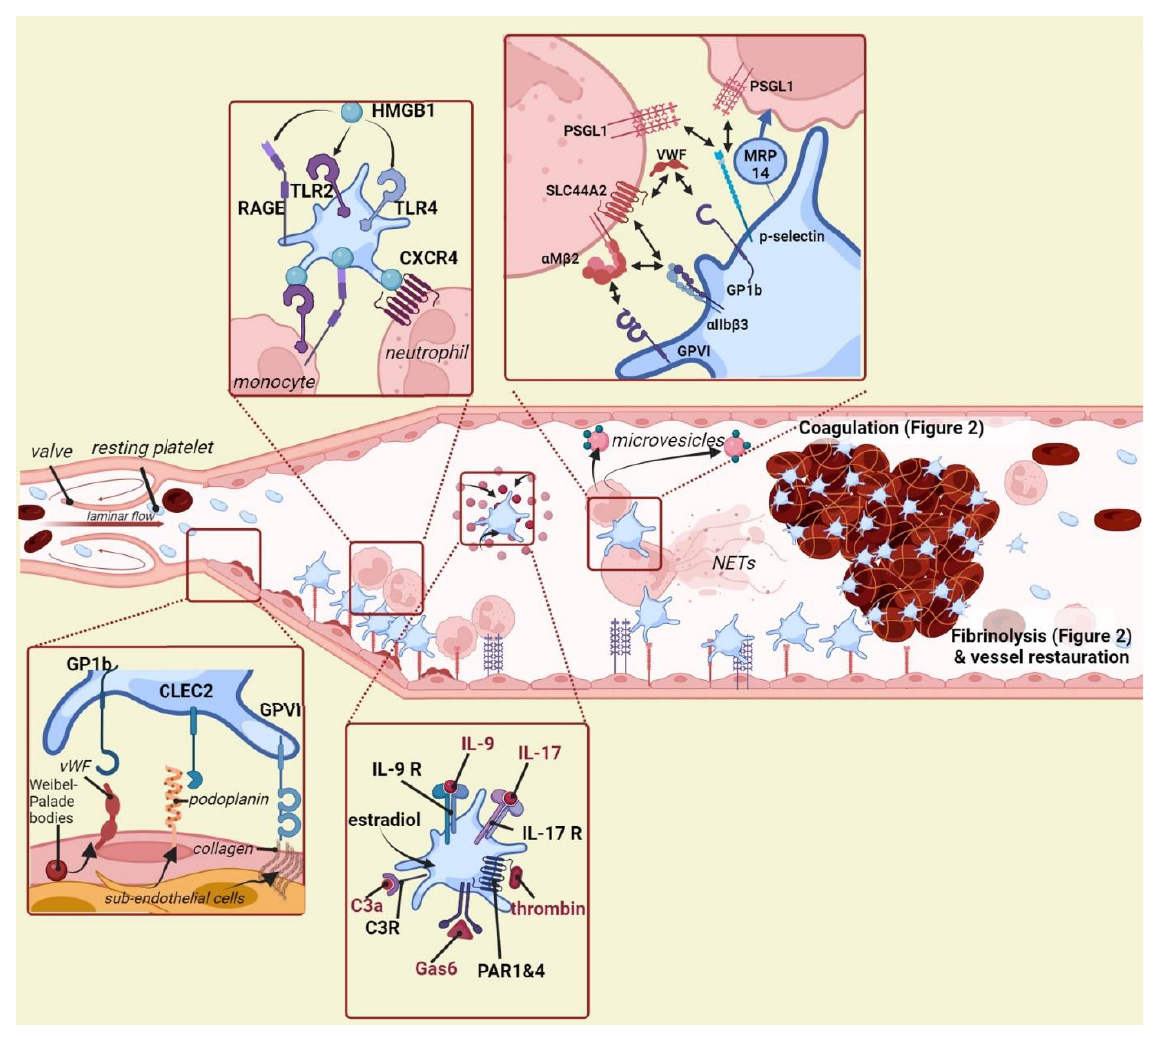
Figure 1. The role of platelets in different aspects of venous thrombosis. Platelets are crucially involved in the pathophysiology of venous thrombosis. They can be recruited to the vessel wall and can interact with neutrophils and monocytes. In addition, activated platelets can mediate venous thrombosis including via stimulation of coagulation and fibrinolysis (see Figure 2).NETs: neutrophil extracellular traps, vWF: von Willebrand factor, GP1b: Glycoprotein 1b, CLEC2: C-type lectin-like receptor 2, GPVI: Glycoprotein VI, RAGE: TLR: Toll-like receptor, HMGB1: High mobility group box 1, CXCR4: C-X-C chemokine receptor type 4, PSGL-1: P-selectin glycoprotein ligand-1, SLC44A2: Solute Carrier Family 44 Member 2, α M β 2: integrin α M β 2 or Mac-1 (macrophage 1 antigen),